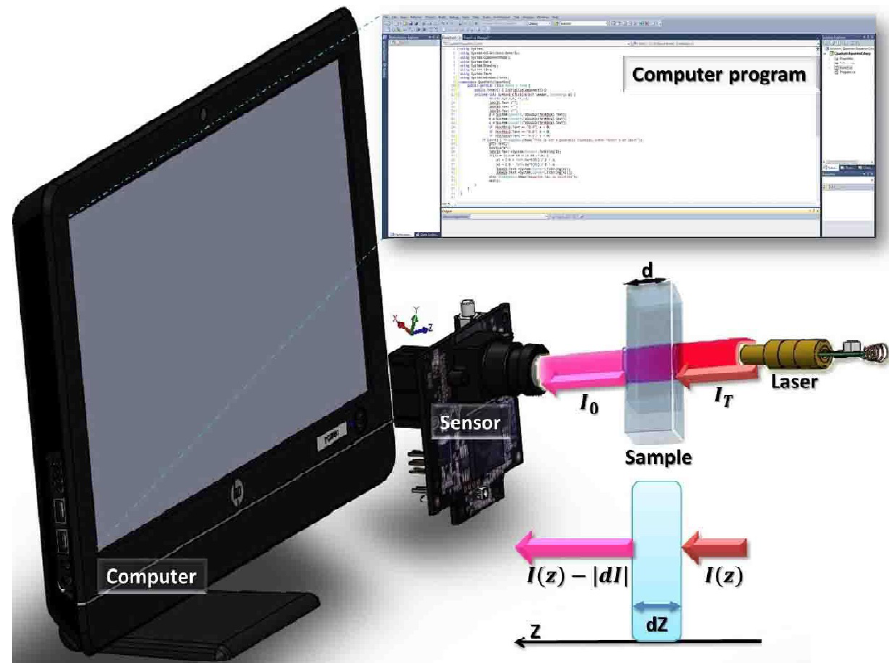
Fig. 1. Scheme systems using attenuation method to determine the optical constants.